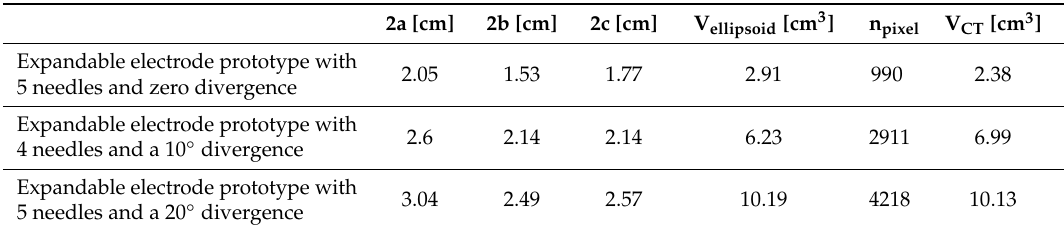
Table 2. Volume of ablated